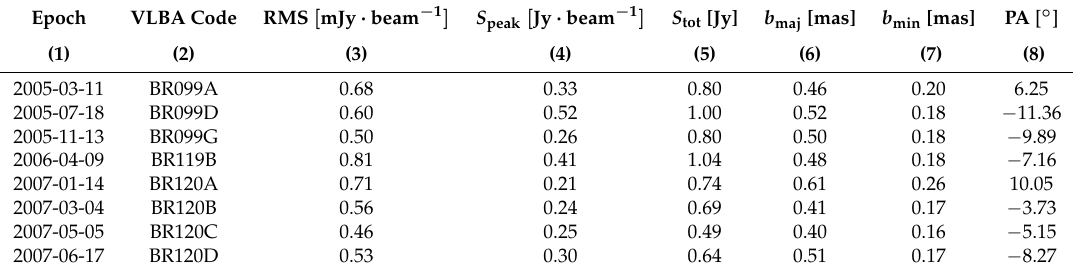
Table 1. Image parameters for all analyzed observations at 43GHz with natural weighting. The RMS is taken from DIFMAP .